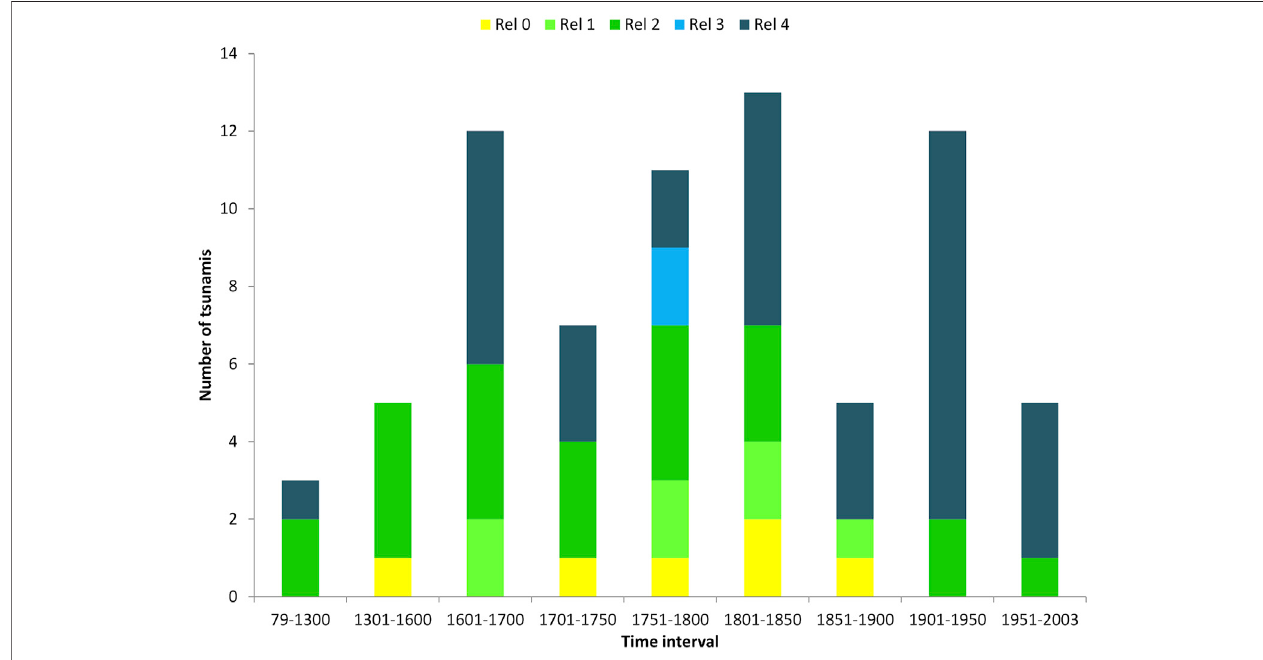
FIGURE6| TimedistributionoftheItaliantsunamisinEMTC2.0perreliabilityclasses,Rel4:de fi nitetsunami,Rel3:probabletsunami,Rel2:questionabletsunami, Rel 1: improbable tsunami, Rel 0: very improbable tsunami.